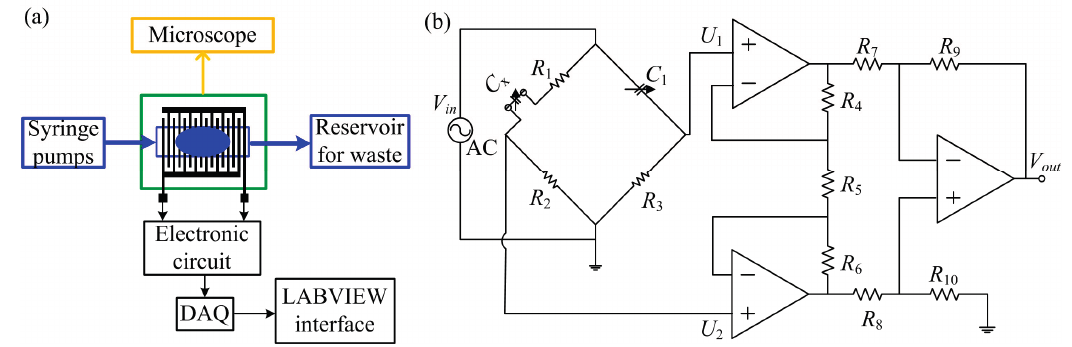
Figure 4. Schematic of the experimental setup. ( a ) Fluids are driven into the microchannel of sensor with two syringe pumps. The droplet flow pattern is visualized with a microscope. And the induced capacitance variation is transformed into voltage variation. Signal is acquired with a DAQ and finally displayed in a computer interface with LABVIEW; ( b ) Electric circuit for signal